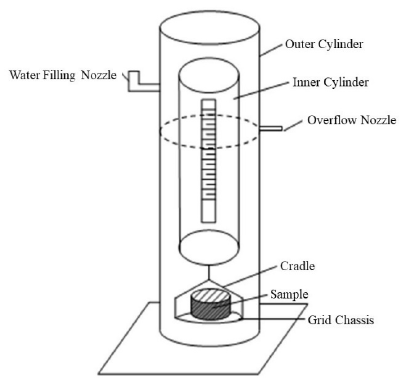
Figure 3. Sketch showing disintegration test apparatus.